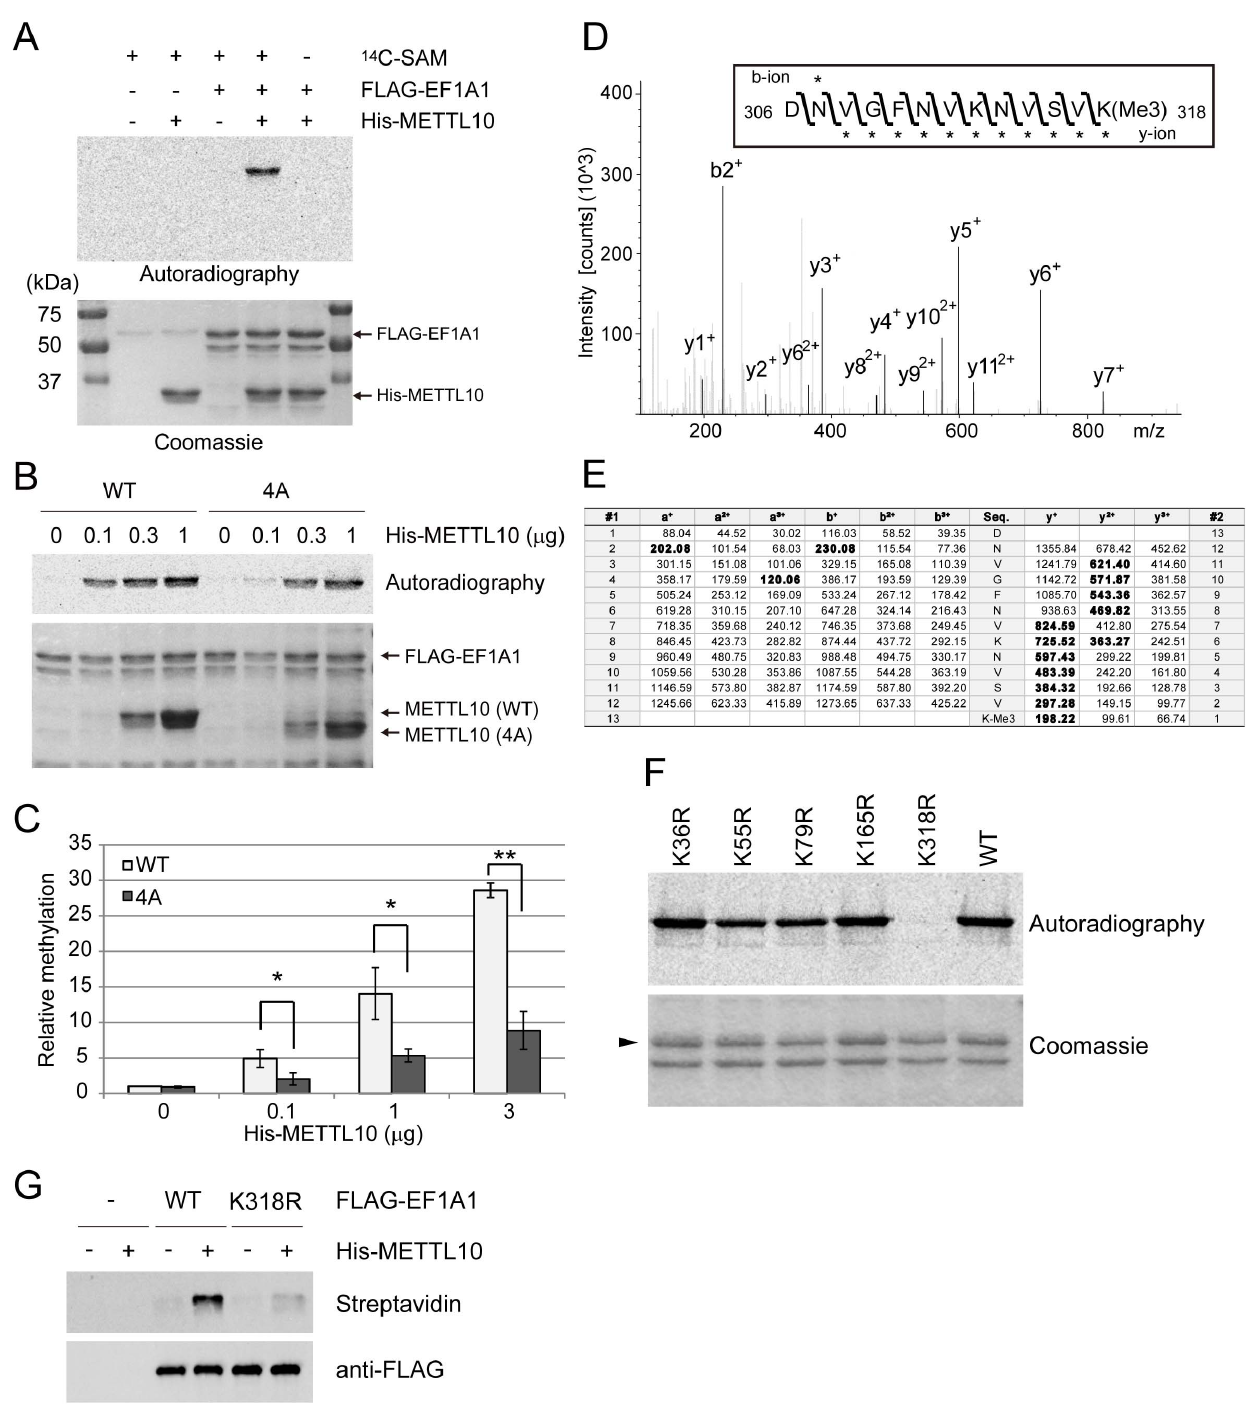
Figure 4. METTL10 tri-methylates K318 in EF1A1. A, METTL10 methylates EF1A1 in vitro . FLAG-tagged EF1A1 and His-METTL10 were incubated with or without 14C-labeled SAM. Proteins were separated with SDS-PAGE and stained with Coomassie blue (bottom), the autoradiography was detected with the image analyzer BAS-5000 (top). B, A conserved SAM-binding domain is important for MTase activity of METTL10. The MTase domain of METTL10 (WT, 85-DIGTGNG-91) was replaced with alanines (4A, 85-AIATANA-91). The representative gel and its autoradiography was detected as in A. C, The relative EF1A1 methylation was quantified by the intensity of autoradiography, and normalized to the intensity by WT 0 m g as 1 (n=3, mean 6 SD, *p , 0.05, **p , 0.01). D, MS/MS spectrum of peptide fragments containing trimethylated lysine 318. Box; Asterisks represent b- and y- ions detected. E. Table of the peptide fragment corresponding to amino acids 306-318. Bold numbers represents fragment ions detected in the experiment. F, METTL10 specifically methylates lysine 318. Five lysine methylation sites (lysine 36, lysine 55, lysine 79, lysine 165 and lysine 318) on EF1A1 were substituted with arginine, and their methylations were examined by autoradiography. G, FLAG-EF1A1 (WT and K318R) were incubated with or without His-METTL10 in the presence of ProSeAM for 2 h at 20 u C. Modified proteins were biotinylated and detected with streptavidin-HRP (top) or anti-FLAG antibody for loading control (bottom). doi:10.1371/journal.pone.0105394.g004 PLOS ONE |